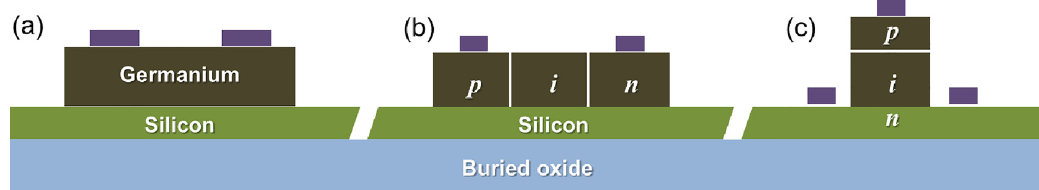
Figure 5: Common types of waveguide-integrated Si – Ge photodetectors. (a) MSM structure, (b) lateral, and (c) vertical p-i-n